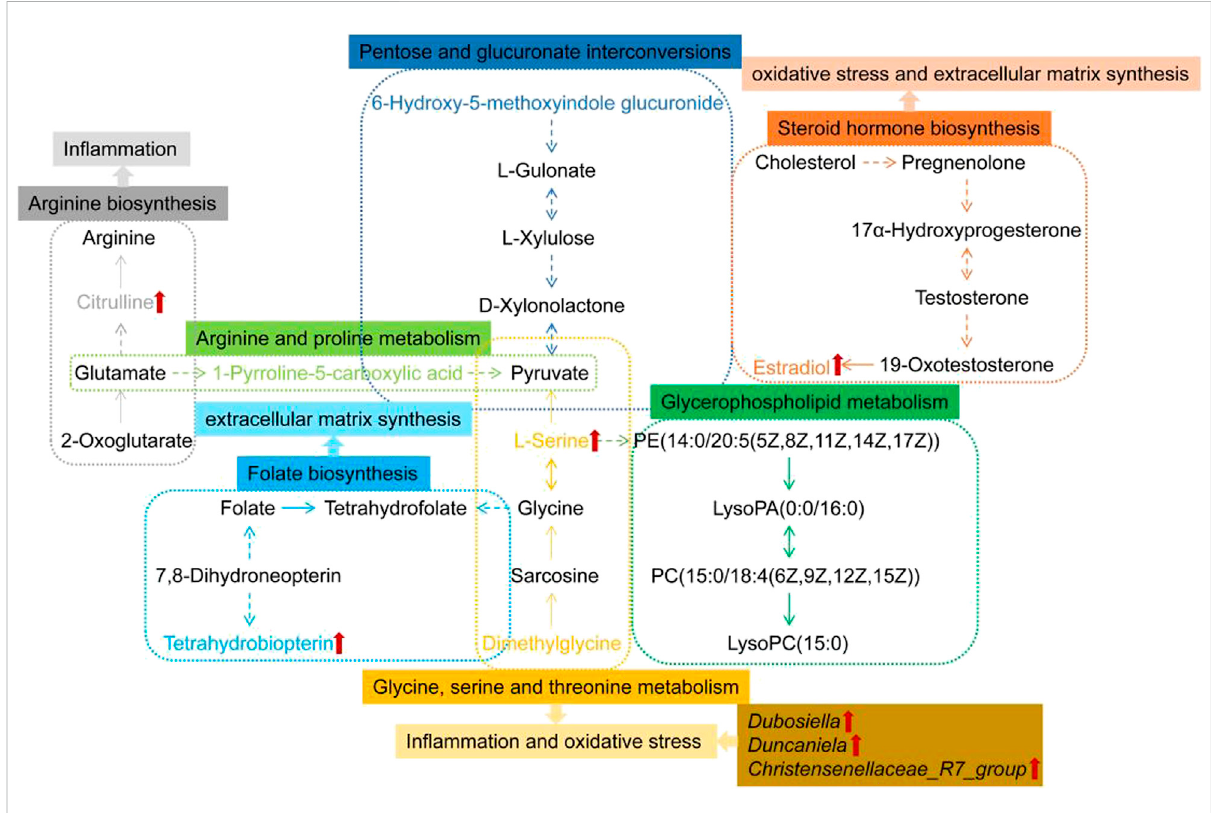
FIGURE 9 Metabolic networks of differential metabolites in response to PF and the preventive effect of A. mongolica oil. Key biomarkers for A. mongolica oil callbacks in red